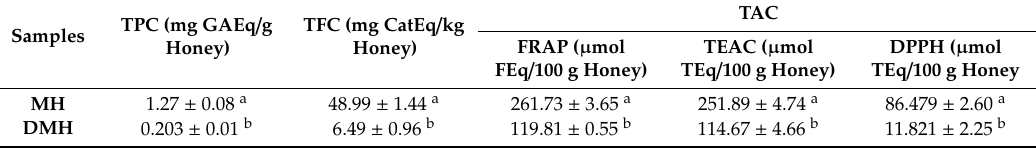
Table 1. Phytochemical composition and antioxidant capacity of MH and